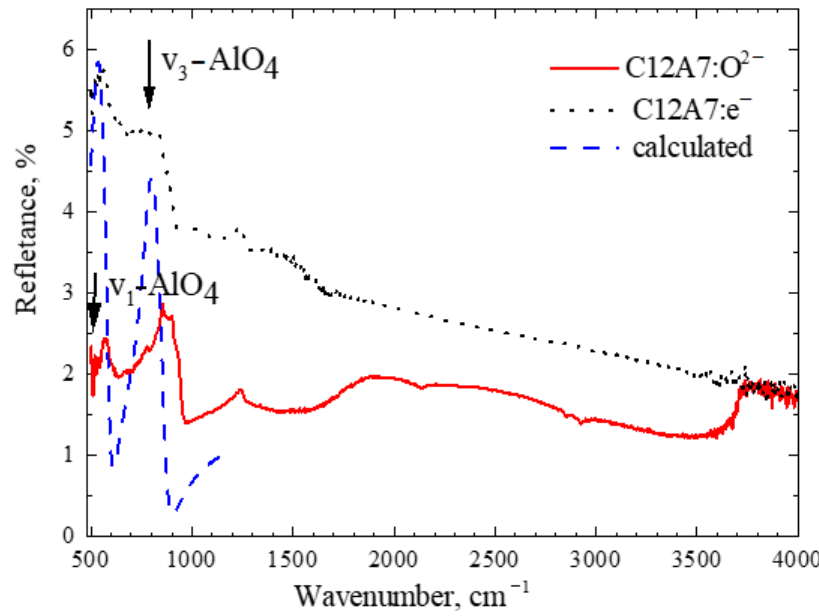
Figure 6. Experimental FTIR reflectance spectra of the samples ( black and red curves) and reflectance calculated in the Drude–Lorentz model ( blue curve, values divided by 10).